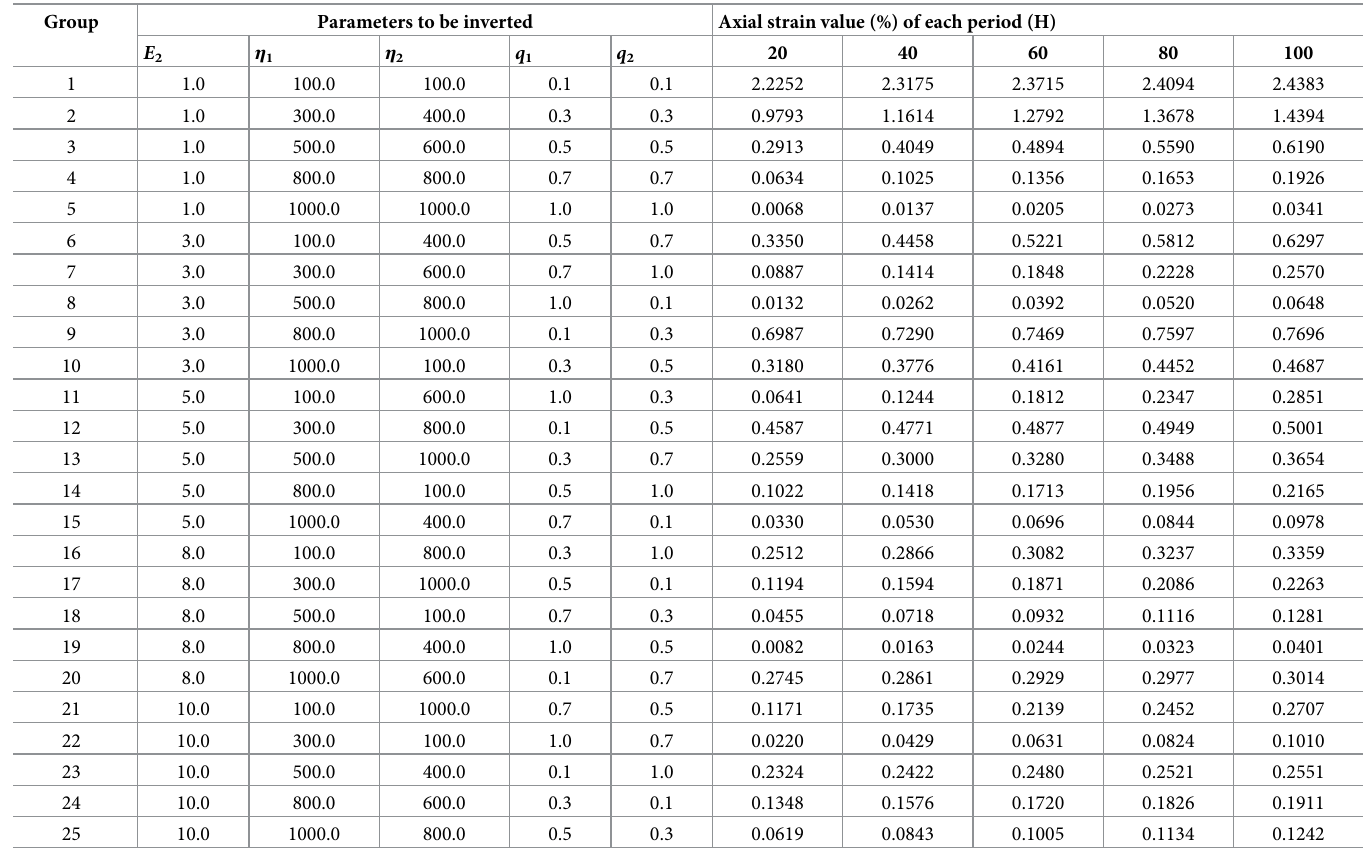
Table 4. Details of test groups used in this study.